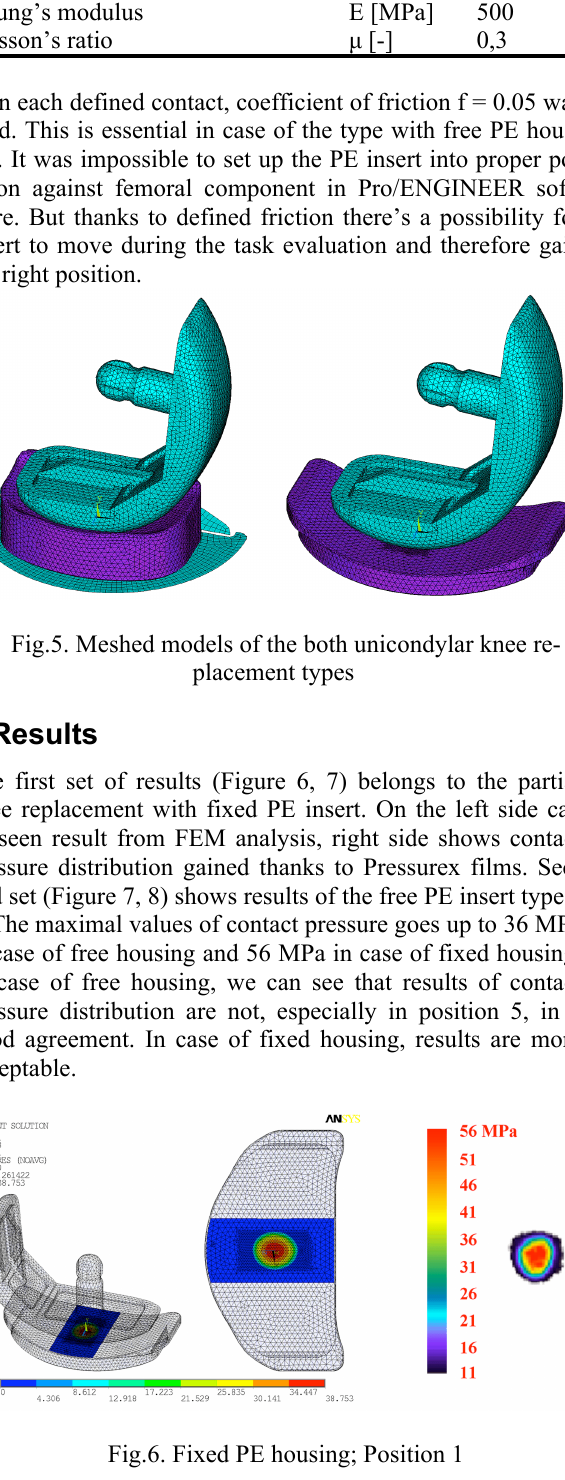
Fig.6. Fixed PE housing; Position 1